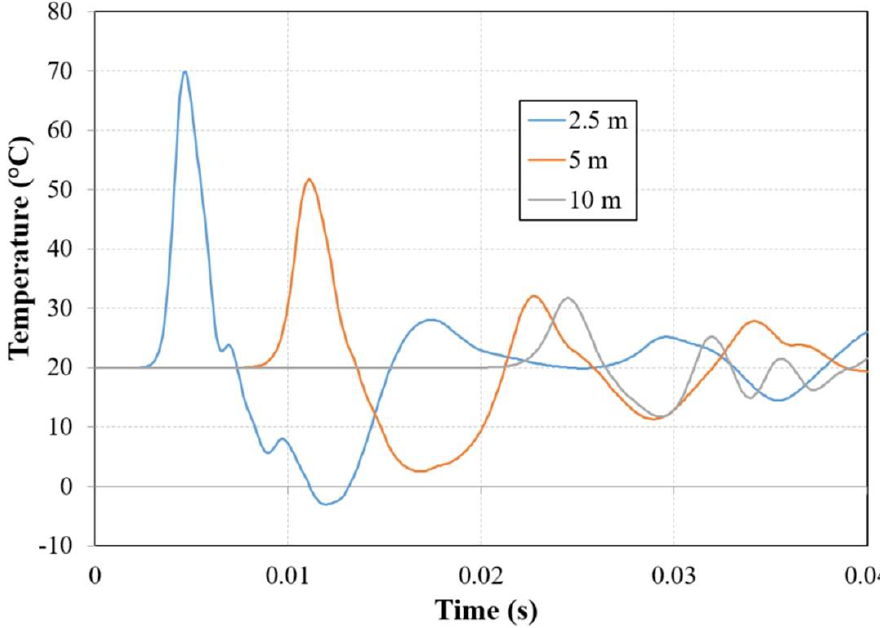
Figure 15. The profile of temperature at the individual obstacles depending on time.